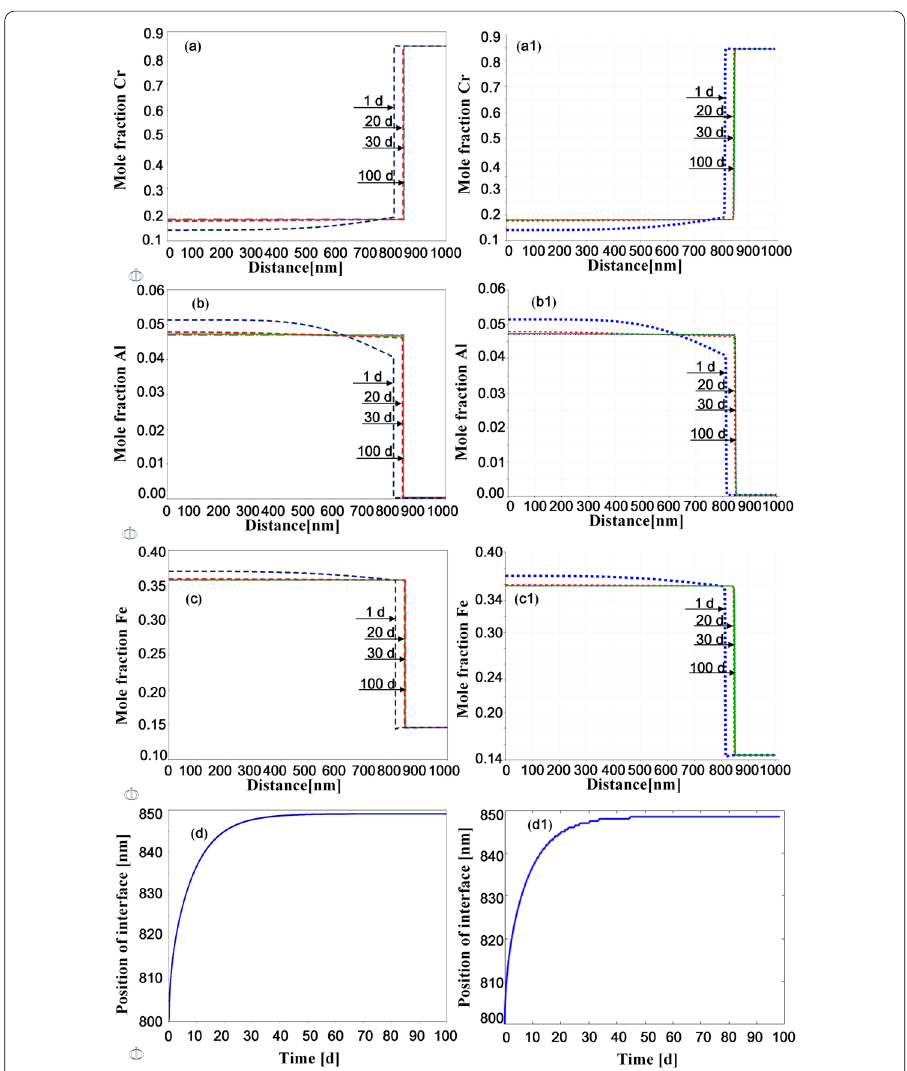
Fig. 4 Comparison of simulation results between DICTRA (a-b-c-d) and Phase field (a1-b1-c1-d1). (a-a1) x Cr (b-b1) x Al and (c-c1) x Fe as a function of position and (d-d1) interface position as a function of time are